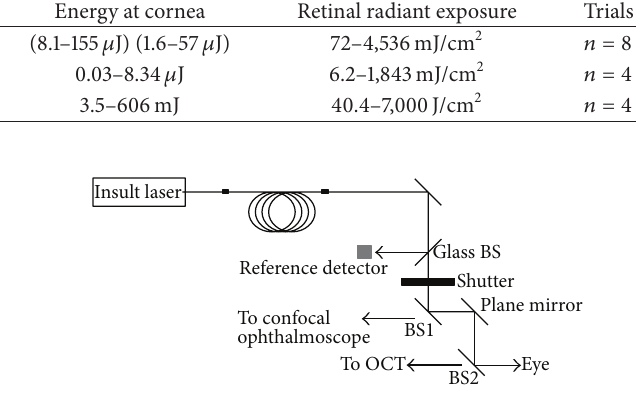
Figure 1: Exposure laser setup and beam introduction into imaging